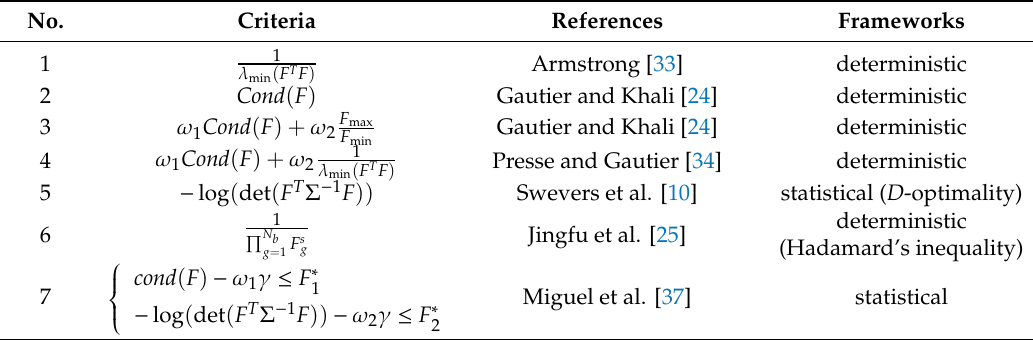
Table 1. Some criteria for the experiment optimization